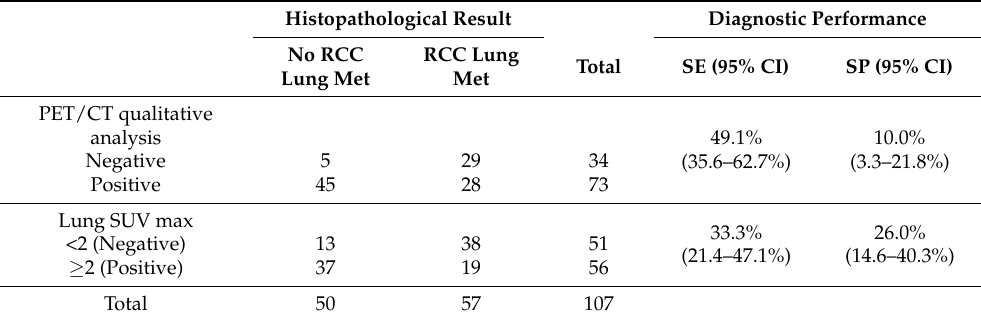
Table 2. Lesion classification and diagnostic performance of the PET/CT lung results and lung SUV max, with the histopathological result as the gold standard to define a lesion as an RCC